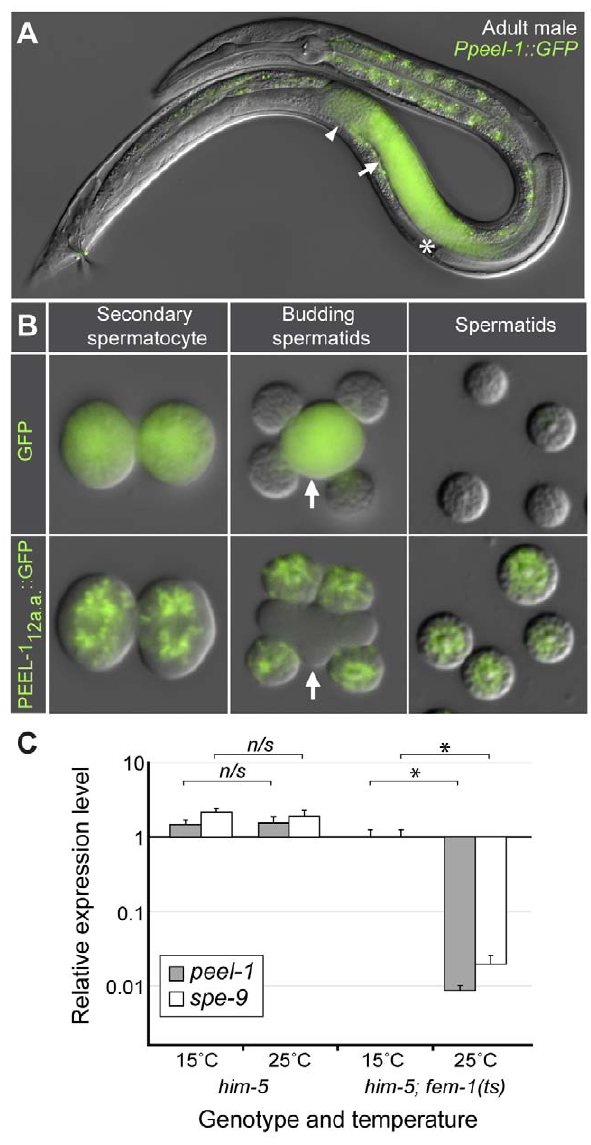
Figure 2. peel-1 is expressed exclusively in sperm and carries an N -terminal sperm localization signal. (A) Adult male expressing Ppeel-1::GFP . The tube-like gonad begins at the asterisk, extends toward the head, folds over on itself, and then extends toward the tail. The arrow and arrowhead indicate spermatocytes and sperm, respectively. Fluorescence outside the gonad is auto-fluorescence. Nomarski and fluorescence channels are overlaid. (B) Secondary spermatocytes, budding spermatids, and mature spermatids expressing either un- tagged GFP or GFP tagged with the N -terminal 12 amino acids of PEEL- 1 (PEEL-1 12a.a. ::GFP) . Arrows indicate residual bodies. Nomarski and fluorescence channels are overlaid. (C) Relative expression levels of peel- 1 and spe-9 in him-5(e1490) and him-5(e1490) fem-1(hc17ts) adult males at the permissive (15 u C) and restrictive (25 u C) temperatures. him- 5(e1490) was included to aid in collection of males. Expression levels were calculated relative to the him-5(e1490) fem-1(hc17ts) 15 u C sample. Runs were performed in triplicate and standard deviations are shown. * p , 10 2 5 , one-tailed Student’s t test on the normalized expression levels. n/s , p .